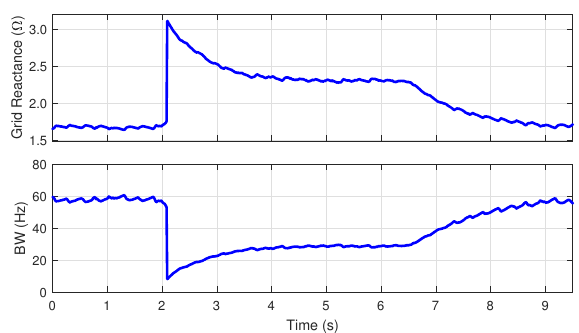
Figure 12. Adaptive control during changes in grid